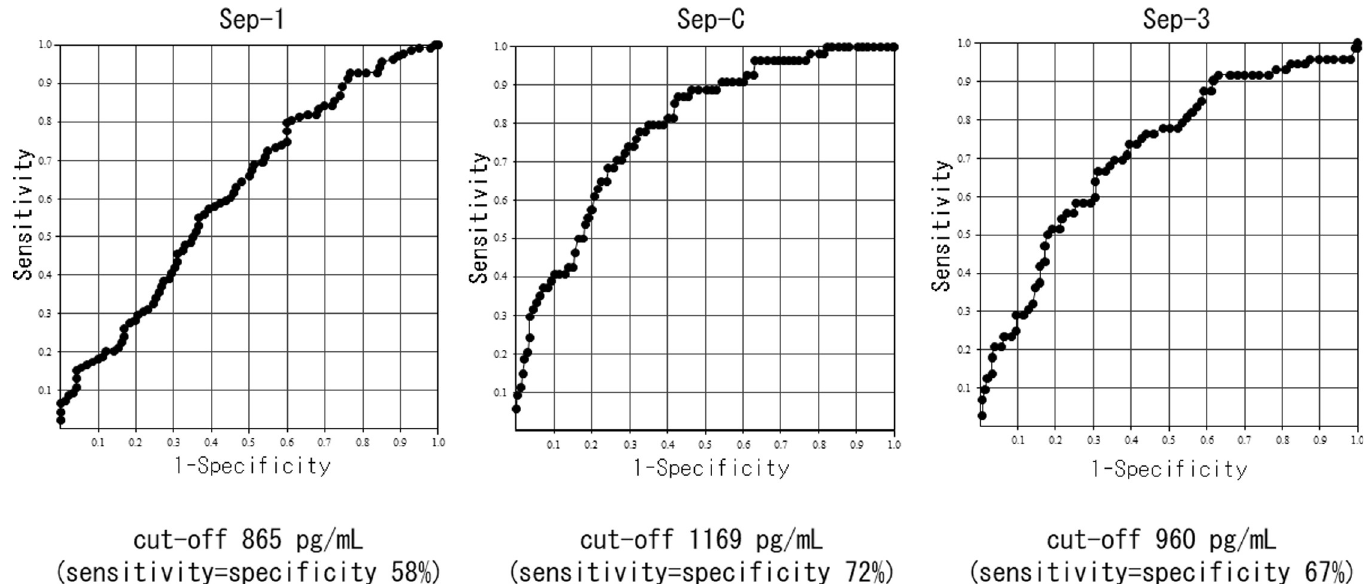
Fig 9. Receiver operator characteristic curve of Pre for each sepsis diagnosis[patients with eGFR < 60 (N = 280)]. AUC: area under the curve. AUCs were as follows: Sep-1: AUC = 0.62 ± 0.03; Sep-C: AUC = 0.79 ± 0.03; Sep-3: AUC = 0.71 ± 0.04.